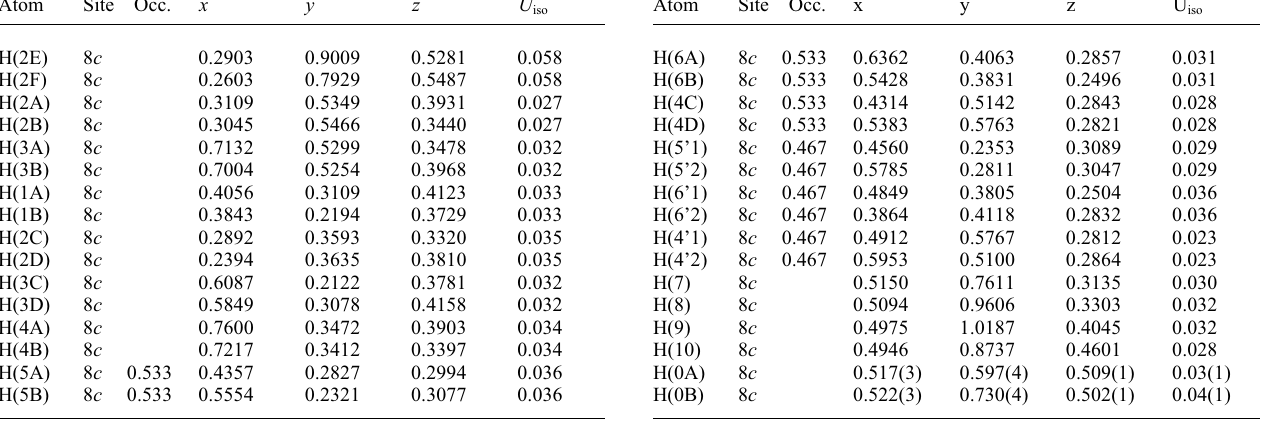
Table 2. Atomic coordinates and displacement parameters (in Å 2 ) . Atom Site